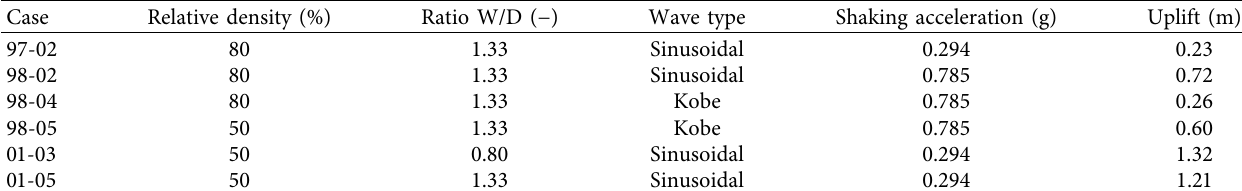
Table 1: Comparisons on uplift displacements for different test conditions (extracted from